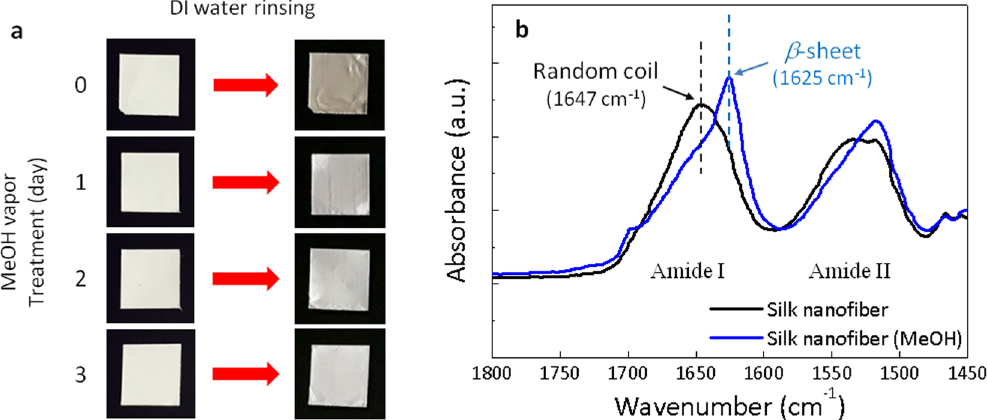
Figure 3. Solubility of the generated FSNs in water. ( a ) Effects of methanol vapor treatments on water solubility of FSNs. ( b ) FT-IR absorbance spectra of FSNs before (black line) and after (blue line) 3 days of methanol treatment. Amide I region indicates the increase of β -sheets, and decrease of random coils during methanol vapor